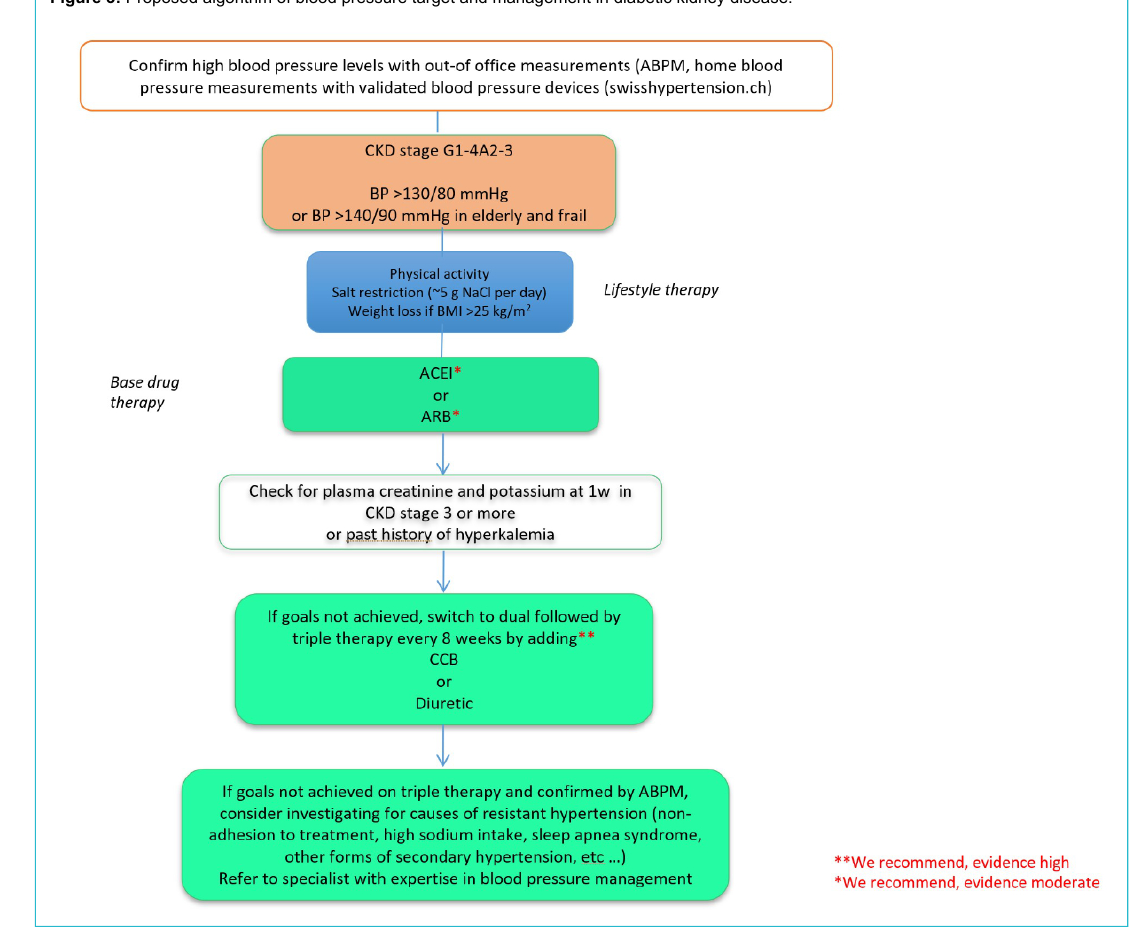
Figure 3: Proposed algorithm of blood pressure target and management in diabetic kidney